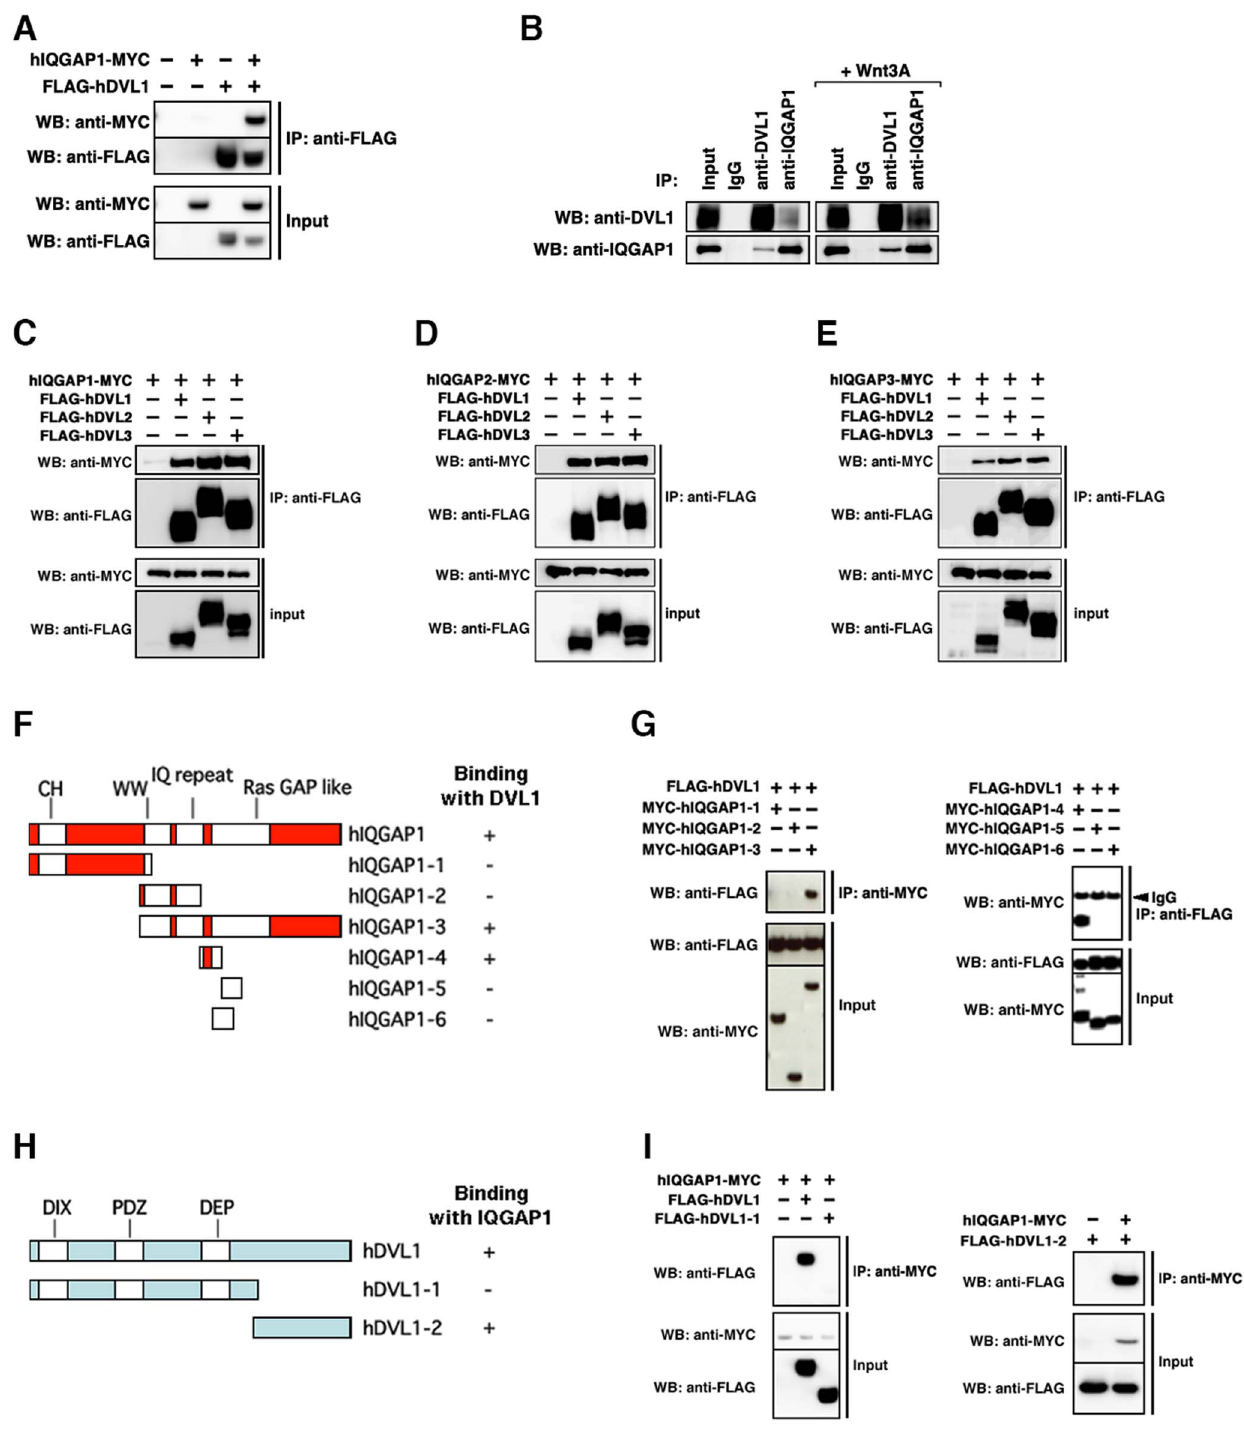
Figure 1. IQGAP associates with DVL. ( A ) Interaction between ectopically-expressed hIQGAP1 and hDVL1 in HEK 293 cells. Immunoprecipitates (IP) obtained using anti-FLAG antibody were subjected to Western blotting (WB) with the indicated antibodies. + , present; -, absent. ( B ) Interaction between endogenous hIQGAP1 and hDVL1 in HEK 293T cells. The cultured cells were stimulated with recombinant human Wnt3A for 6 hours (right panels). ( C–E ) Interaction between ectopically-expressed hIQGAP1, hIQGAP2, hIQGAP3 and hDVL isoforms in HEK 293T cells. (C) hIQGAP1. (D) hIQGAP2. (E) hIQGAP3. ( F ) A schematic of the domains of hIQGAP1 and truncated constructs. ( G ) Interactions between ectopically-expressed hDVL1 and truncated hIQGAP1 constructs. ( H ) Interactions among ectopically-expressed hIQGAP1 and truncated hDVL1 constructs. ( I ) A schematic of the domains of hDVL1 and truncated constructs.